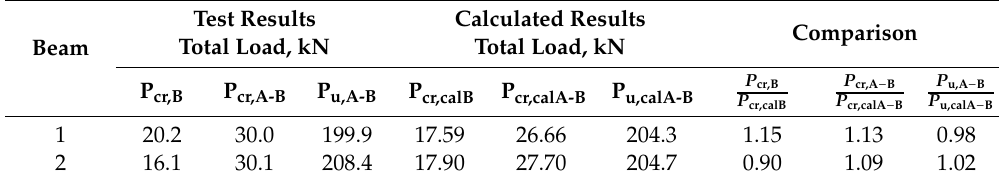
Table 2. Comparison of calculated and experimental results.